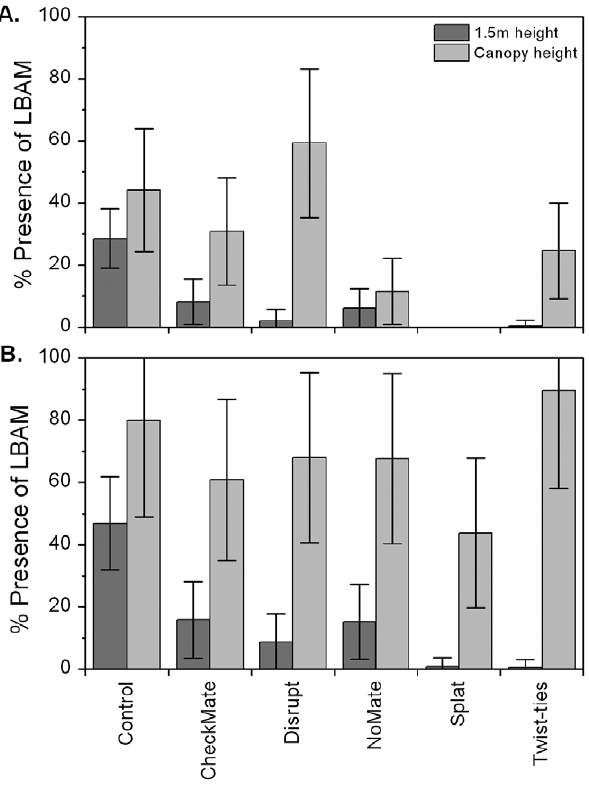
Figure 3. Covariate-adjusted percent presence (mean 6 S.E.) of light brown apple moth in traps near ground level and at canopy height. Data shown are for weeks 1–5 (A) and for weeks 6–10 following pheromone application